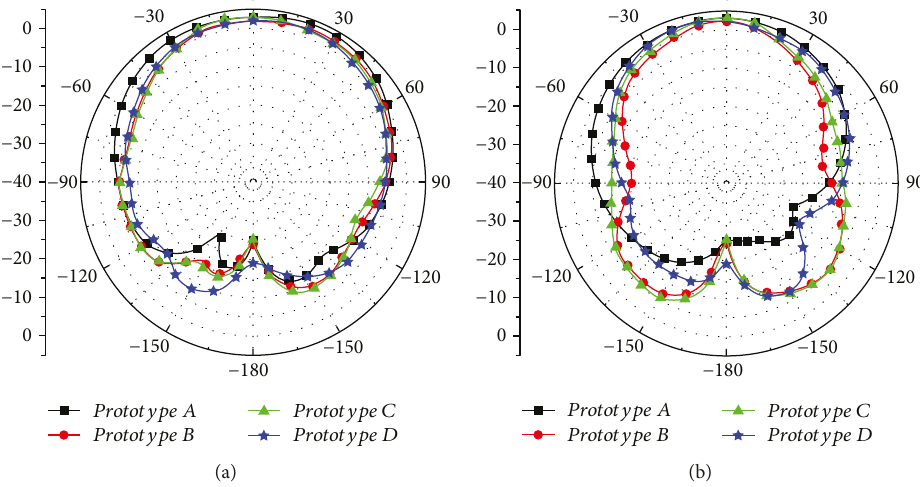
Figure 9: Far- fi eld radiation patterns of the three antennas in (a) xoz plane and the (b) yoz